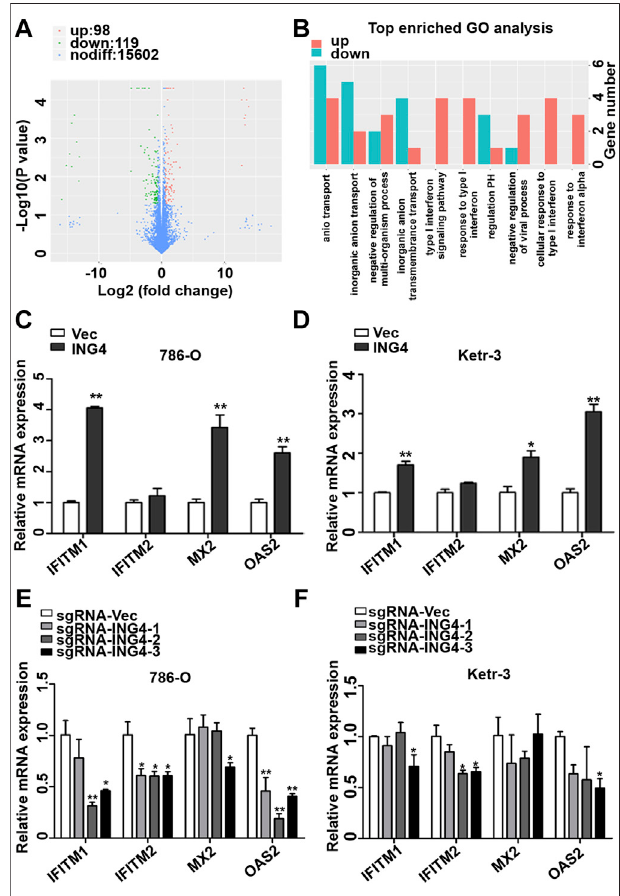
FIGURE 4 | ING4-increased ISG expression. (A) The volcano plot was used to indicate the signi fi cantly differential gene expressions in 786-O cells. (B) GO analysis was used to identify the functional enrichments in the biological process, the vertical coordinate was the enriched GO term, andthehorizontalcoordinatewasthenumberofsigni fi cantlydifferentgenesin that term. (C – D) The real-time PCR analyzed the mRNA expression levels of ISGs, including OAS2, MX2, IFITM1, and IFITM2 in ING4-overexpressed (ING4) 786-O and Ketr-3 cells compared to the respective vector controls (Vec). (E – F) The relative mRNA expression levels of ISGs in ING4 knockdown (sgRNA-ING4) Ketr-3 and 786-O cells were compared to the respective vector control (sgRNA-Vec). Data are presented as mean ± standard deviation. * p < 0.05, ** p <